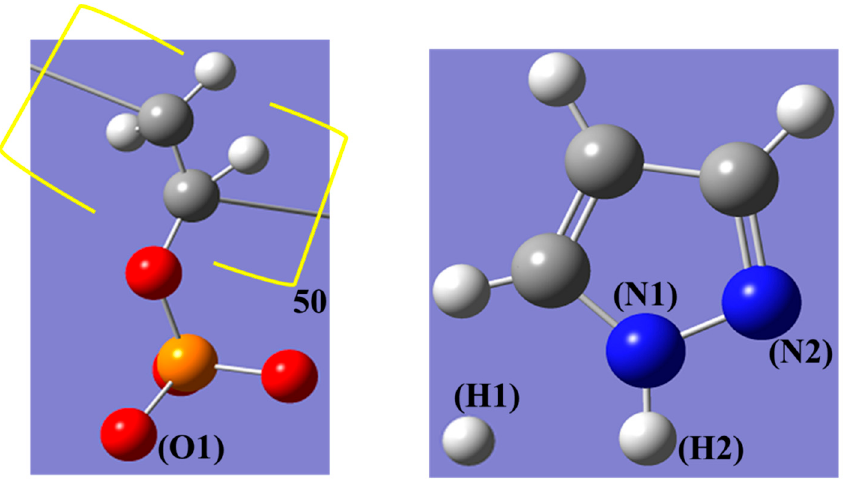
Figure 1. Atomic site symbols of poly(vinyl phosphonate anion) (PVPA), pyrazole (Py) and proton.